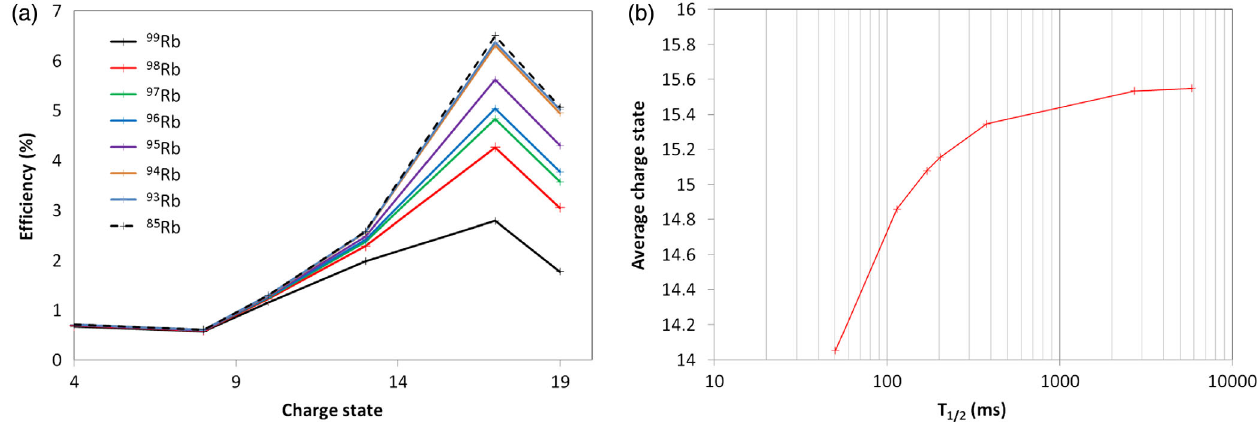
13. (a) Rb isotope efficiencies as a function of the charge state. (b) Evolution of the average charge state as a function of the